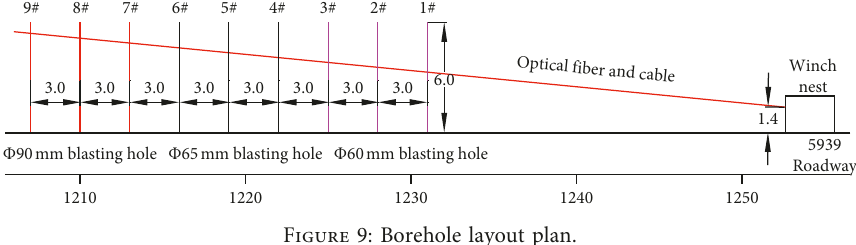
Figure 9: Borehole layout